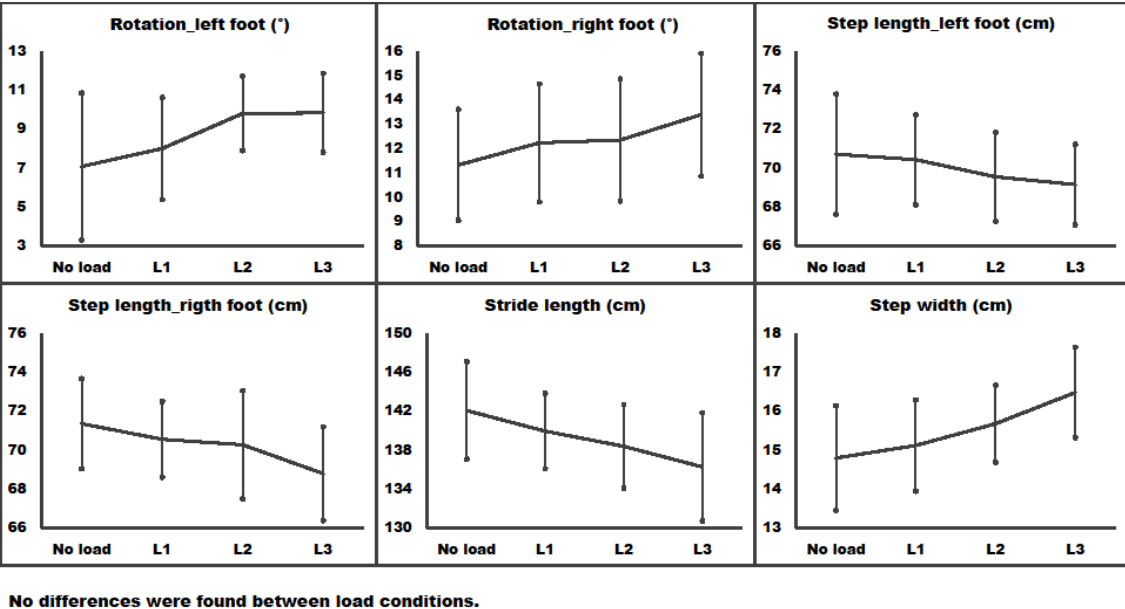
Figure 1. Changes in spatial gait parameters under different loading conditions of no load (only body weight), L1 (5 kg load), L2 (25 kg load) and L3 (45 kg load), (N = 30). Time changes for temporal gait parameters under different loading conditions are presented in Figure 2. Similar to spatial variables, more mass added resulted in nonsig- nificant time effects for step length of the left foot ( F 1,3 = 0.467, p = 0.706, η 2 = 0.012) and right foot ( F 1,3 = 1.377, p = 0.254, η 2 = 0.045), stride time ( F 1,3 = 0.958, p = 0.416, η 2 = 0.033), cadence ( F 1,3 = 1.293, p = 0.281, η 2 = 0.041), and gait speed ( F 1,3 = 0.949, p = 0.420, η 2 = 0.039).